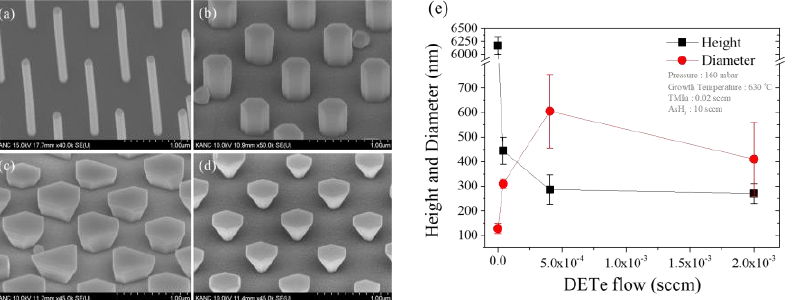
Figure 3. Tilted-view SEM images of grown NWs on seed NWs; ( a ) 3 min grown un-doped InAs NWs and Te-doped InAs NWs with each DETe flow; ( b ) 4.04 × 10 − 5 sccm, ( c ) 4.04 × 10 − 4 sccm, and ( d ) 2.00 × 10 − 3 sccm. ( e ) A plot showing NWs’ heights as a function of the flow of DETe. The growth of InAs NWs has been studied via the pitch distance dependence [39]. S.